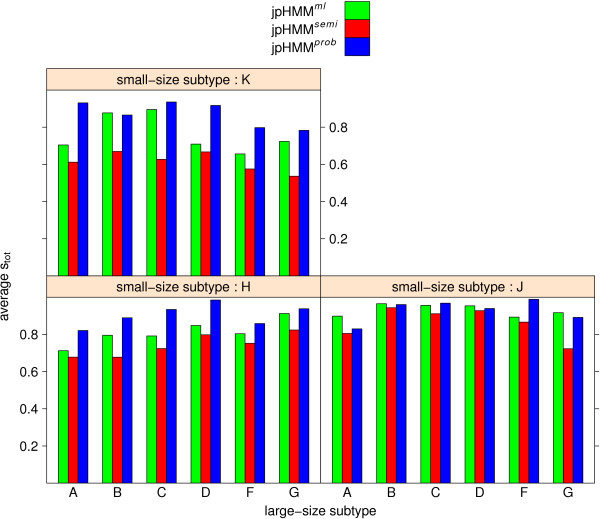
The stratified performance of different versions of jpHMM onTrec. The performance (measured in stot) of jpHMM ml, jpHMM semi, and jpHMM prob on Trec is shown, with the semi-artificial recombinant sequences Trec being stratified by which small- and which large-size subtype was used for the generation of the respective sequence.